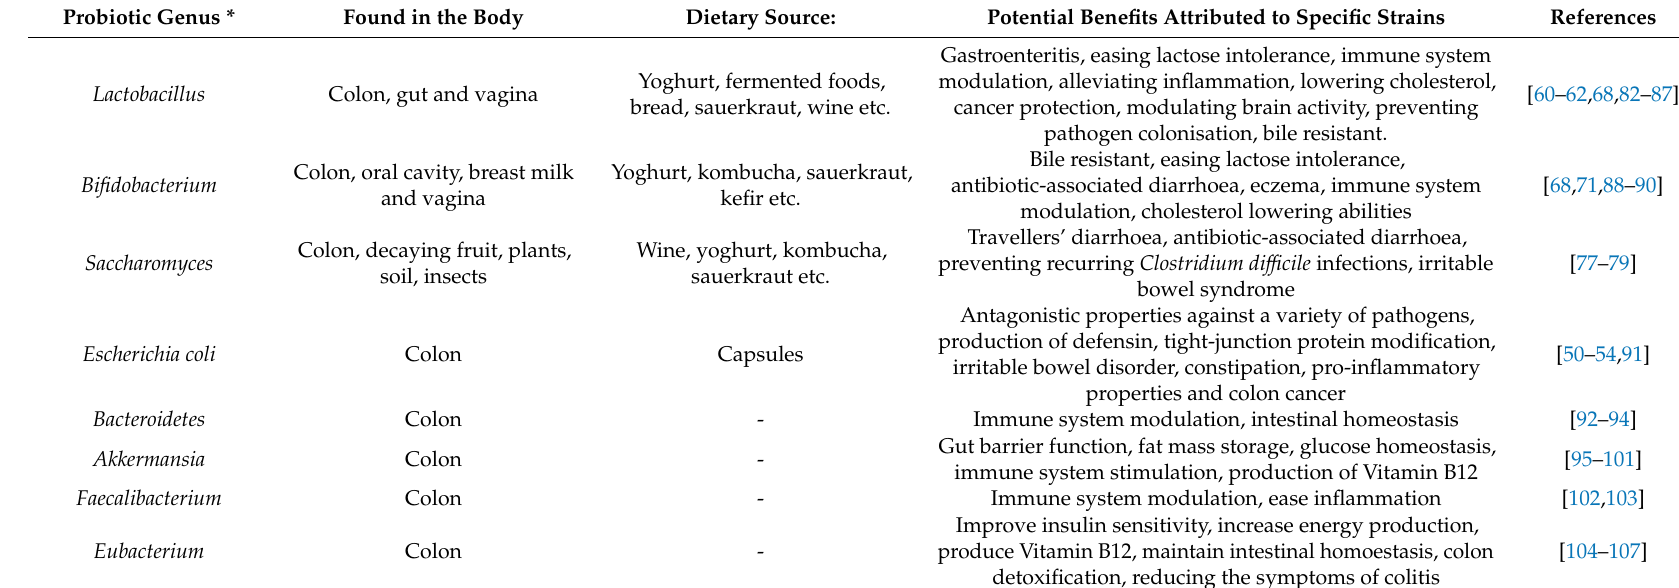
Table 2. Traditional probiotics and next-generation probiotics and their